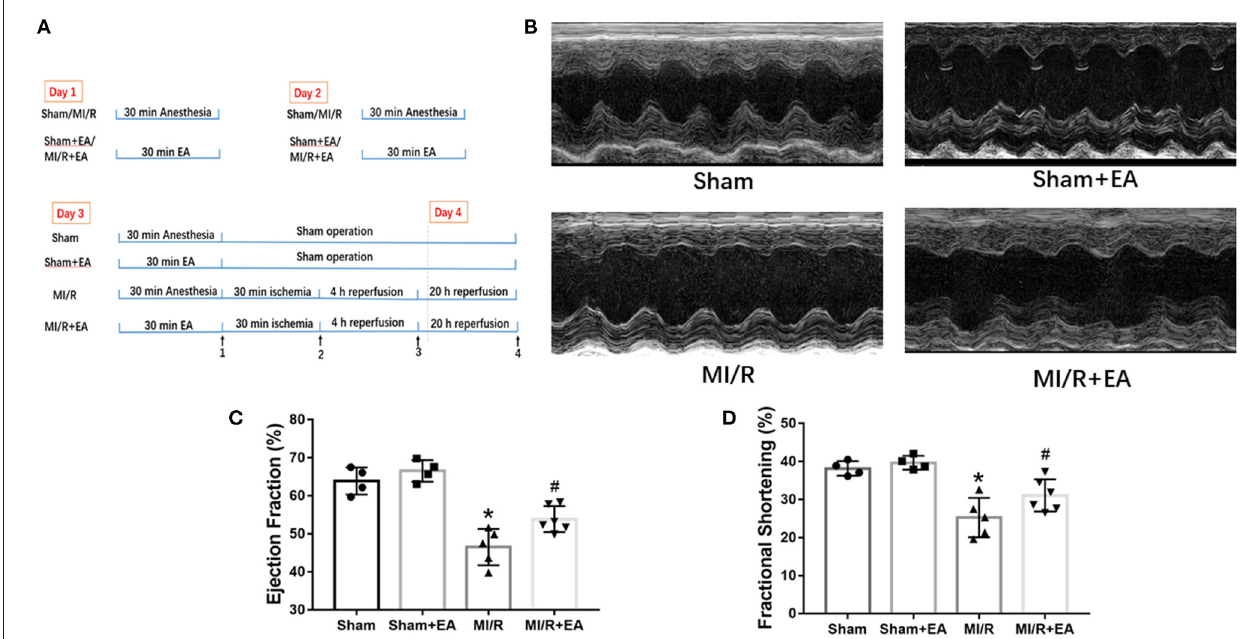
FIGURE 1 | EA pretreatment mitigated MI/R-induced cardiac dysfunction. (A) A schematic illustration of the study groups and in vivo experimental protocols. Time point 1: ischemic phase. Time point 2: reperfusion phase. Time point 3: heart tissue collection for protein analysis. Time point 4: echo analysis and TTC staining. (B) Representative images of M-mode echocardiography in MI/R-induced cardiac injury following EA pretreatment. Images of M-mode echocardiography were recorded from horizontal direction of the heart and then were analyzed to assess cardiac systolic function. (C) Ejection fraction. (D) Fractional shortening. n = 4–6 in each group. EA, electroacupuncture; MI/R, myocardial ischemia/reperfusion; TTC, triphenyltetrazolium chloride. * P < 0.05 vs. Sham group, # P < 0.05 vs. MI/R group.